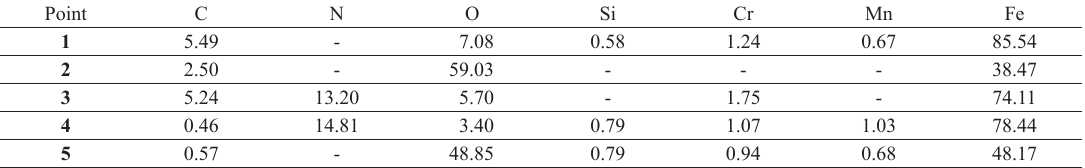
Table 3. EDS results (at. %) of the untreated and nitrided specimens of the marked area (1-5) on the worn surface from the Figure 10. Point